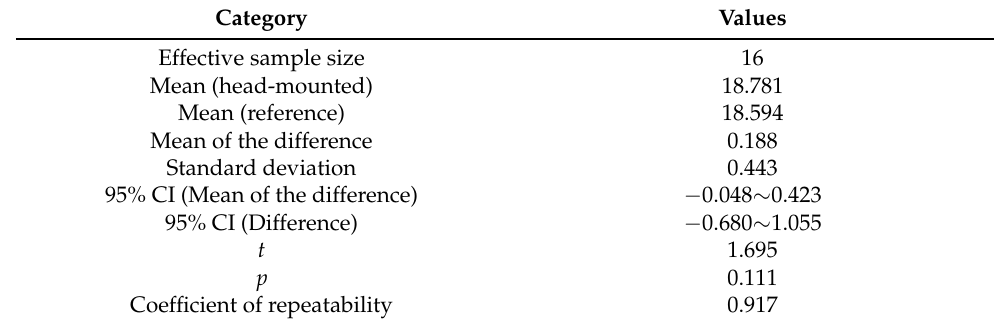
Table 2. Statistical information of the measurement results from the two devices.